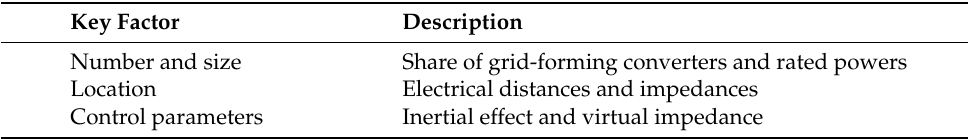
Table 1. Investigation factors with critical